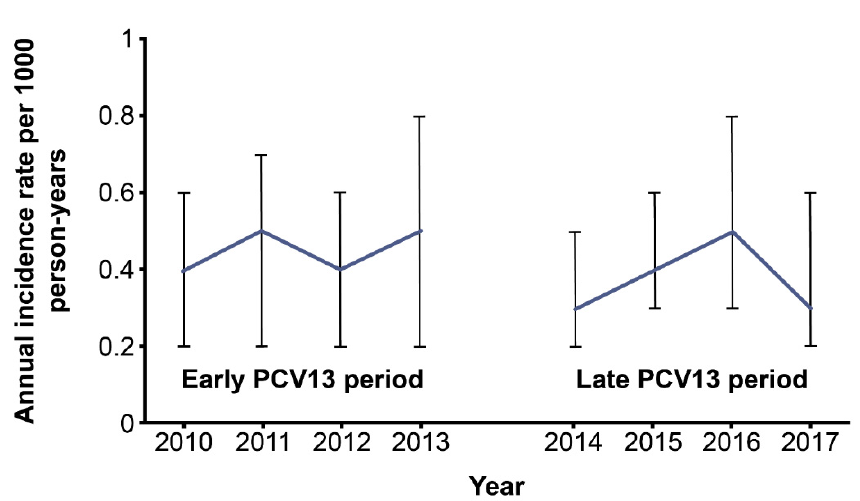
Figure 1. ITS trend for the mean annual pneumococcal-specific and syndromic invasive disease incidence in children. ITS, interrupted time series; PCV13, 13-valent pneumococcal conjugate vaccine. Error bars indicate 95% confidence intervals.